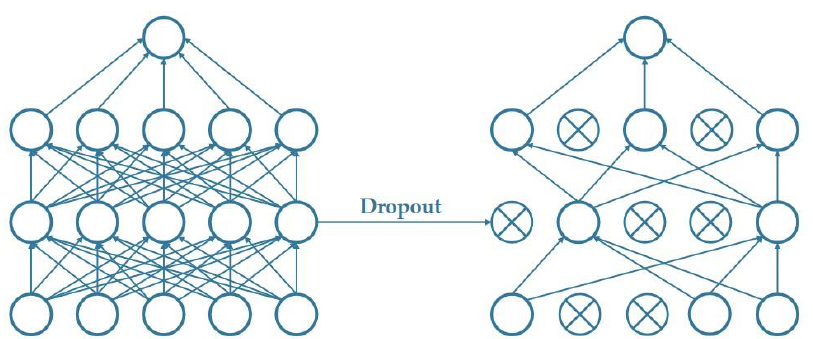
Figure 4. An example of a fully connected layer before and after dropout.